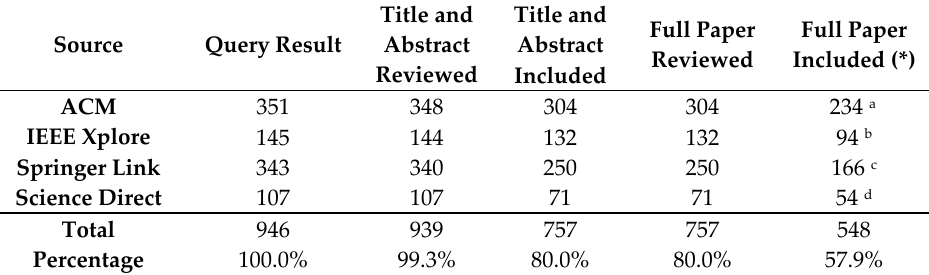
Table 1. Distribution of papers by